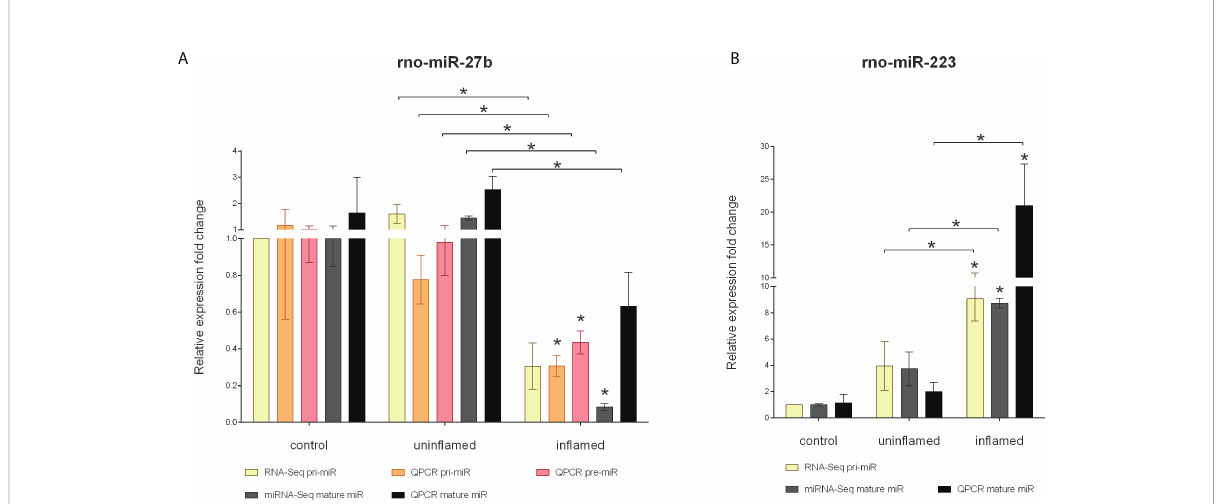
FIGURE 4 Expression changes of precursors and mature miR-27b and miR-223 in the in fl amed colons of experimentally induced rat model of IBD. Relative expression of pri-, pre- and mature miR-27b (A) is shown from control (left columns), unin fl amed (middle columns) and in fl amed (right columns) rat colon sections; yellow and gray columns represent RNA-Seq and miRNA-Seq data, while orange, red and black present QPCR results. On panel (B) , relative expression of pri-and mature miR-223 is shown from control (left columns), unin fl amed (middle columns) and in fl amed (right columns) rat colon sections; yellow and gray columns represent RNA-Seq and miRNA-Seq data, while black presents QPCR results. Data are presented as the mean ± SEM; * p <0.05.